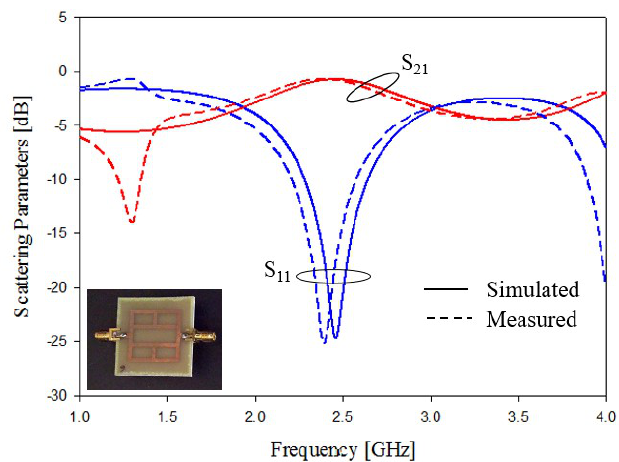
Figure 19. Experimental assessment, T-shaped stubs of length equal to L perpendicular to the feeding line, prototype of Figure 7b. Comparisons between numerical and measured scattering parameters. Table 5. Optimized filter performances: ε r = 4.0, h = 1.6